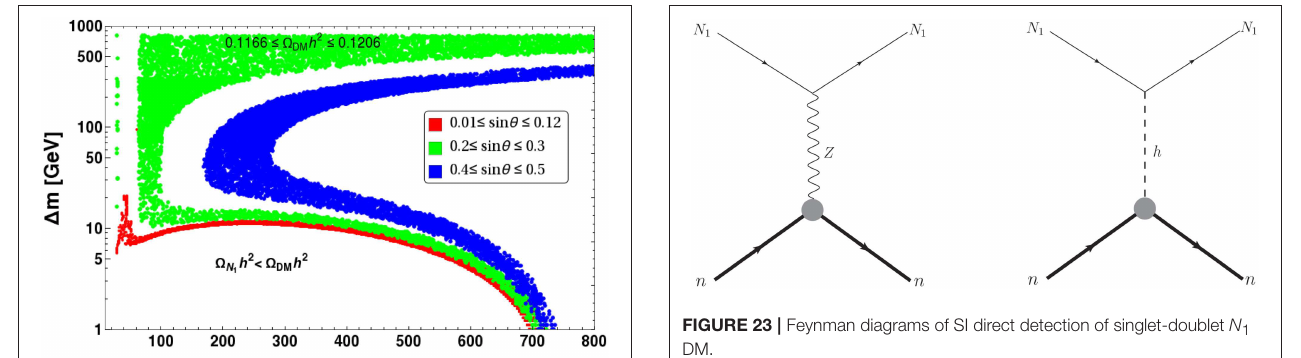
FIGURE 22 | Relic density allowed region are shown in m N different range of range of sin θ : 0.4 0.5 (Blue). { − }